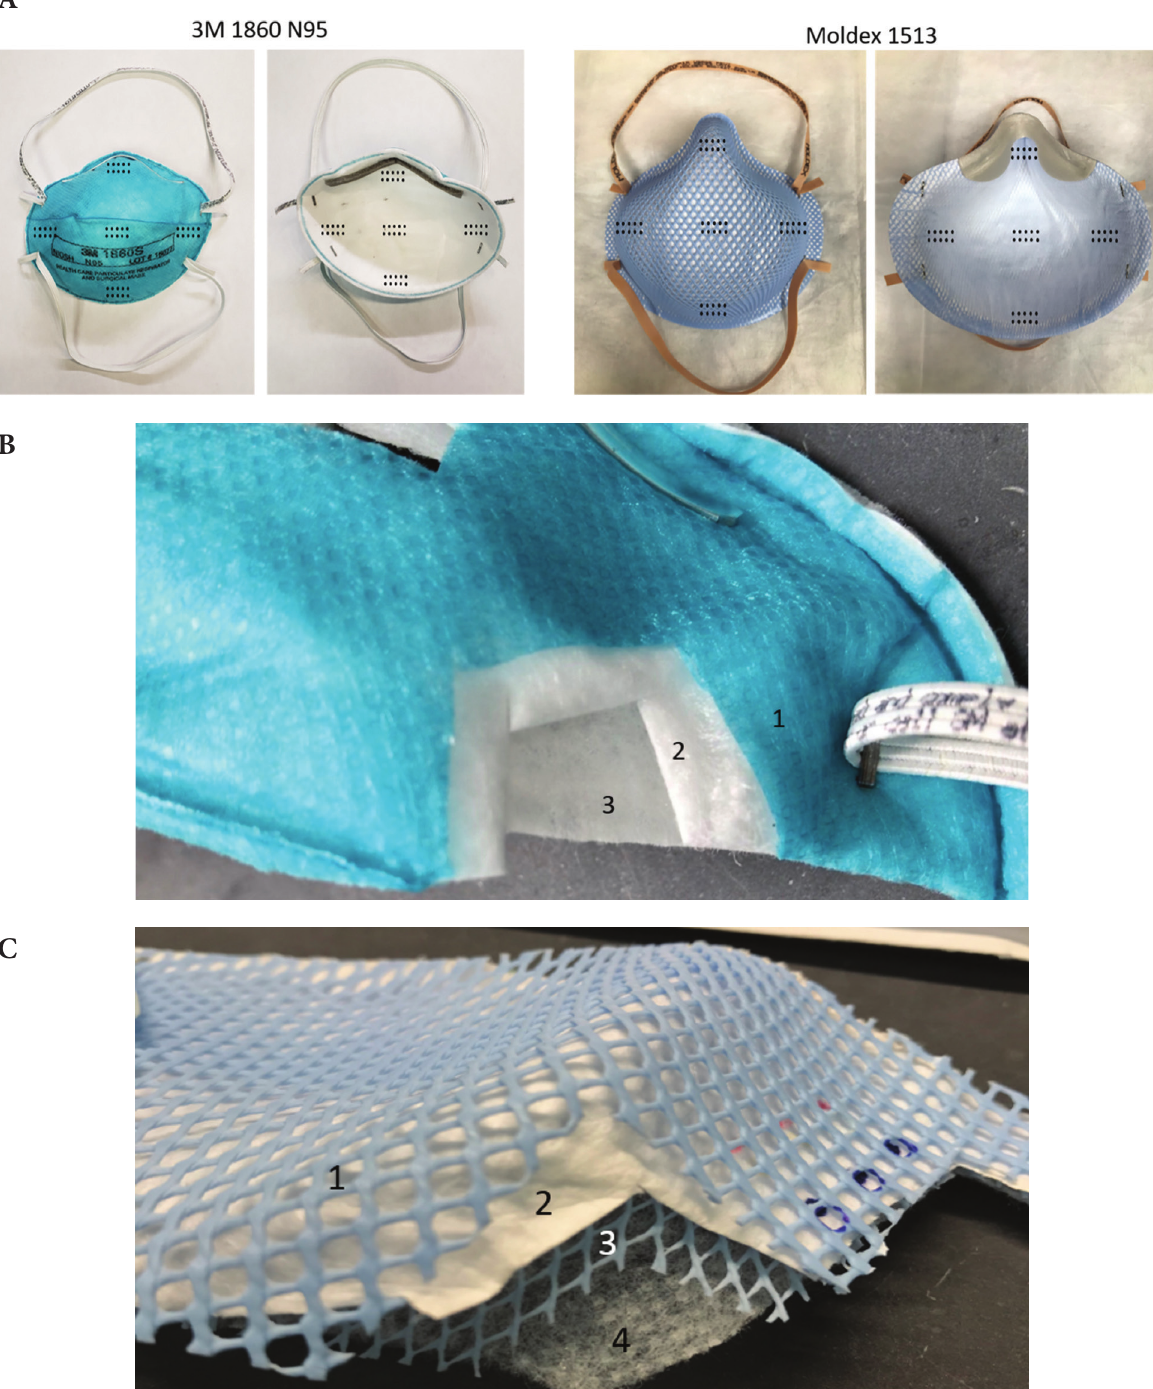
Figure 2. Pictures of the 3M 1860 and Moldex 1513 N95 respirators and the sites of inoculation on exterior and interior facepiece surfaces (A) and internal fibers (B and C). For the internal fiber inoculation, the respirators were cut open, inoculated, and sealed. Panel B: 1, exterior facepiece layer; 2, internal layer; 3, interior facepiece layer. Panel C: 1, exterior structural layer (blue); 2, exterior facepiece layer; 3, internal structural layer (blue); 4, interior facepiece